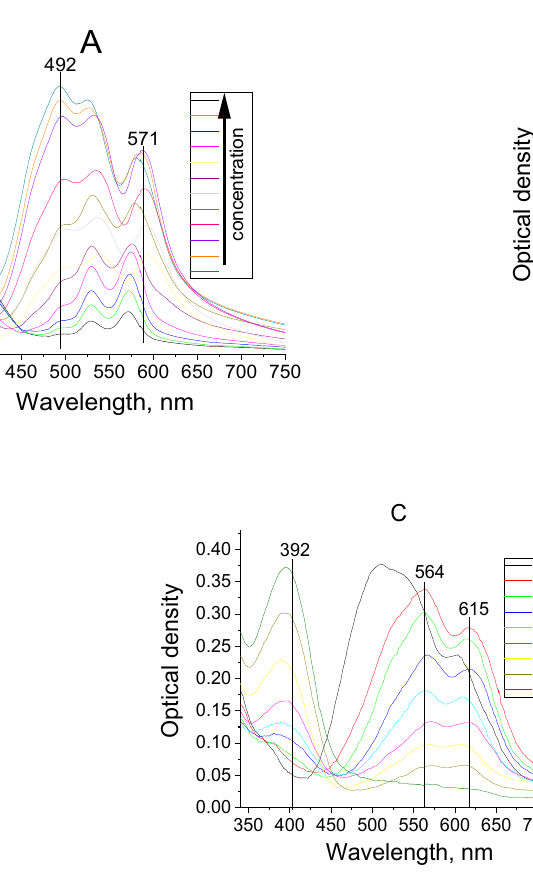
Figure 6. Absorption spectra of Alq 3 composite films with different concentrations of guest dyes I ( A ), II ( B ), IV ( C ).